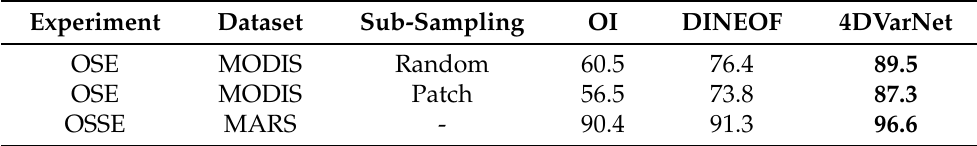
Table 1. R-score performance in % for the considered methods and validation configurations. OSE refers to the real data (MODIS) interpolating process. The sub-sampling strategy is described in Section 3.2. OSSE dataset refers to the previous work [19] based on the MARS results.